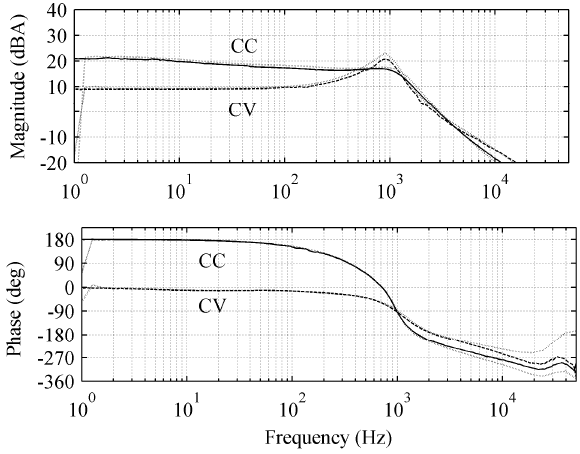
G ) of a boost-power-stage converter co-o